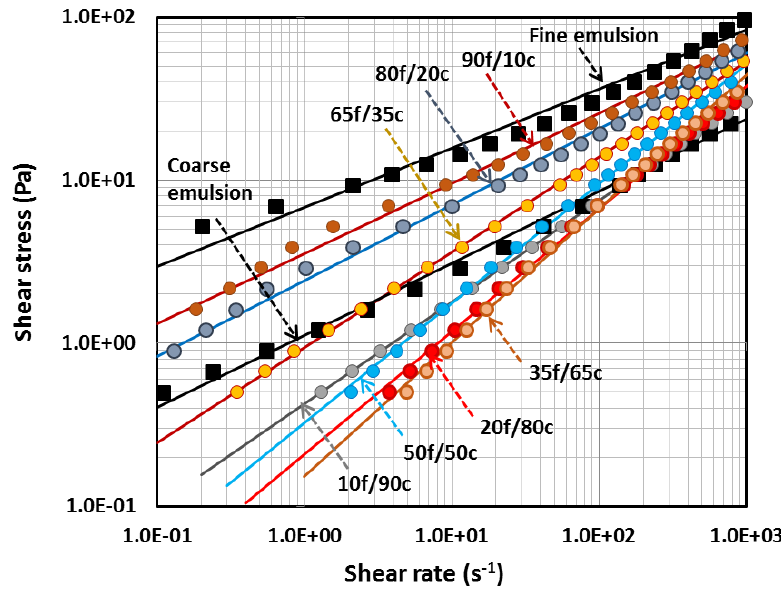
Figure 4. Shear stress versus shear rate plots for mixtures of fine and coarse O/W emulsions. In the figure “f” refers to proportion of fine emulsion and “c” refers to proportion of coarse emulsion. Table 1. Goodness of fit of power-law model and confidence intervals for the power-law parameters.